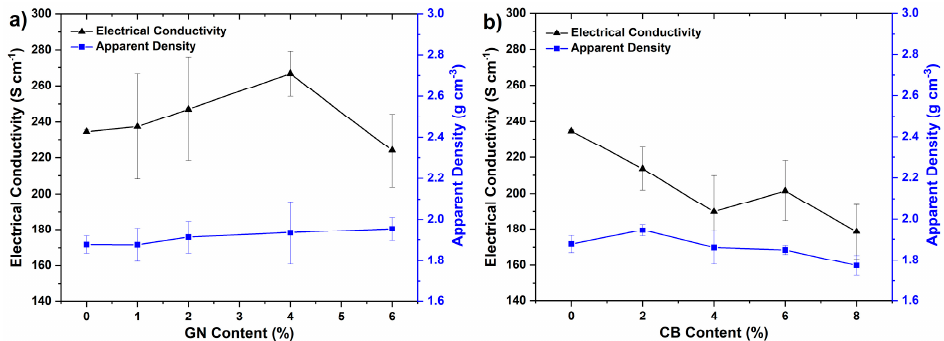
Figure 4. Electrical conductivity and apparent density of composites depending on the content of secondary nanofillers: ( a ) graphene nanoplatelets, ( b ) carbon black.